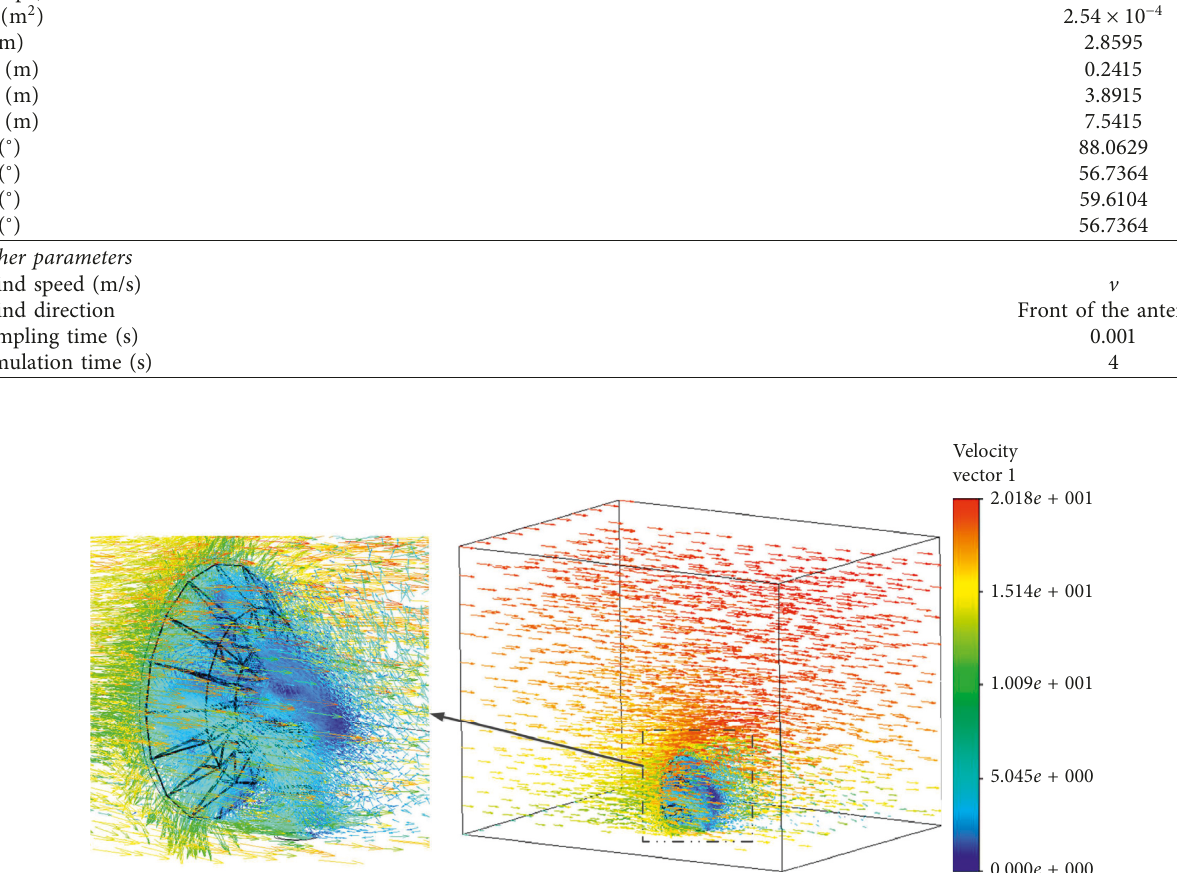
Figure 3: Wind field of the